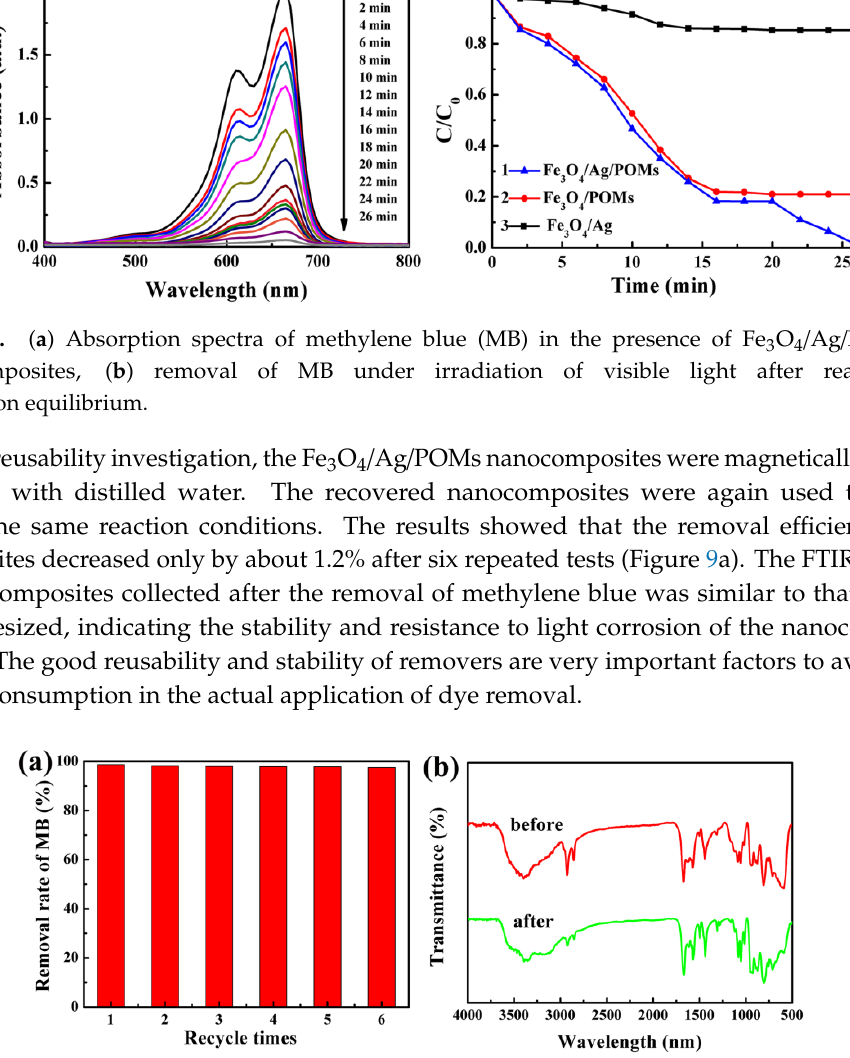
Figure 9. ( a ) Histogram of recycling to remove MB for six cycles and ( b ) FTIR spectra as-synthesized Fe 3 O 4 /Ag/POMs and after cyclic removal of MB six times with the Fe 3 O 4 /Ag/POMs nanocomposites.